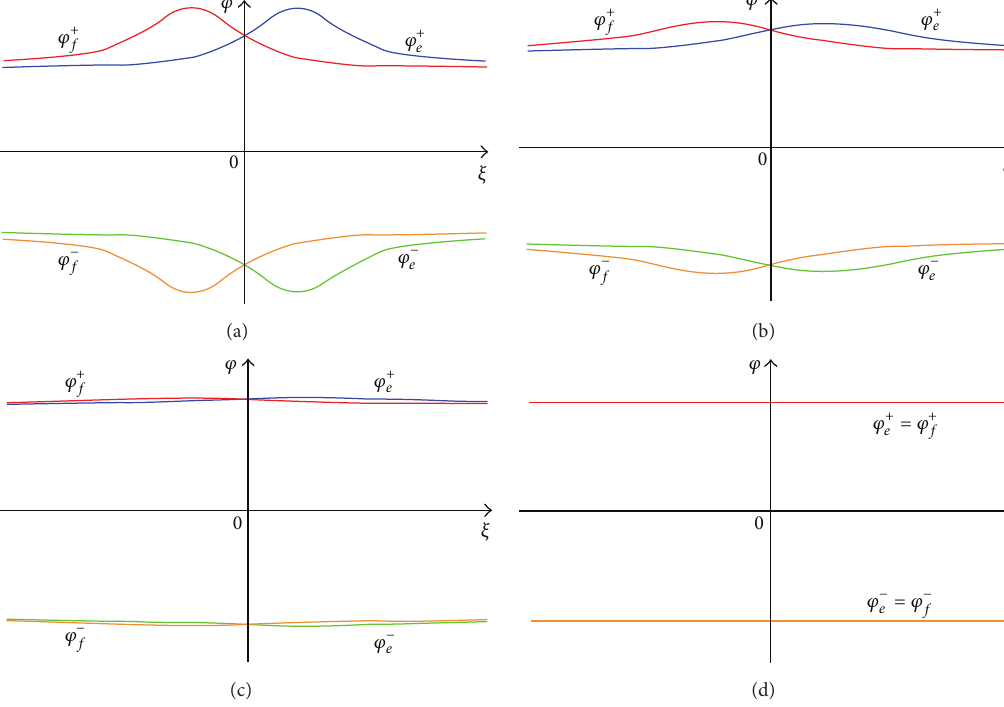
Figure 11: (The four symmetric solitary waves become two trivial waves.) The varying process for the figures of 𝜑 ± 𝑒 and 𝜑 ± 𝑓 when 𝜇 > |, (𝑞,𝑝) ∈ 𝐴 𝑝 → 𝑞 2 /4𝑟 + 0 , where 𝑟 = −1 , 𝑞 = 4, 𝑙 0, 𝜇 ̸=|𝜇 0 11 , and 𝑝 = −4 + 10 −2 , and (d) 𝑝 = −4 + 10 −5